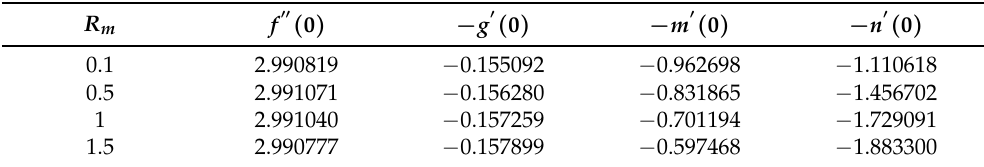
Table 8. Estimated values for f (cid:48)(cid:48) ( 0 ) , − g (cid:48) ( 0 ) , − m (cid:48) ( 0 ) , and − n (cid:48) ( 0 ) with fixed S z = − 0.1, M x = 0.5, M y = 0.3, S = 1, and different values of R m